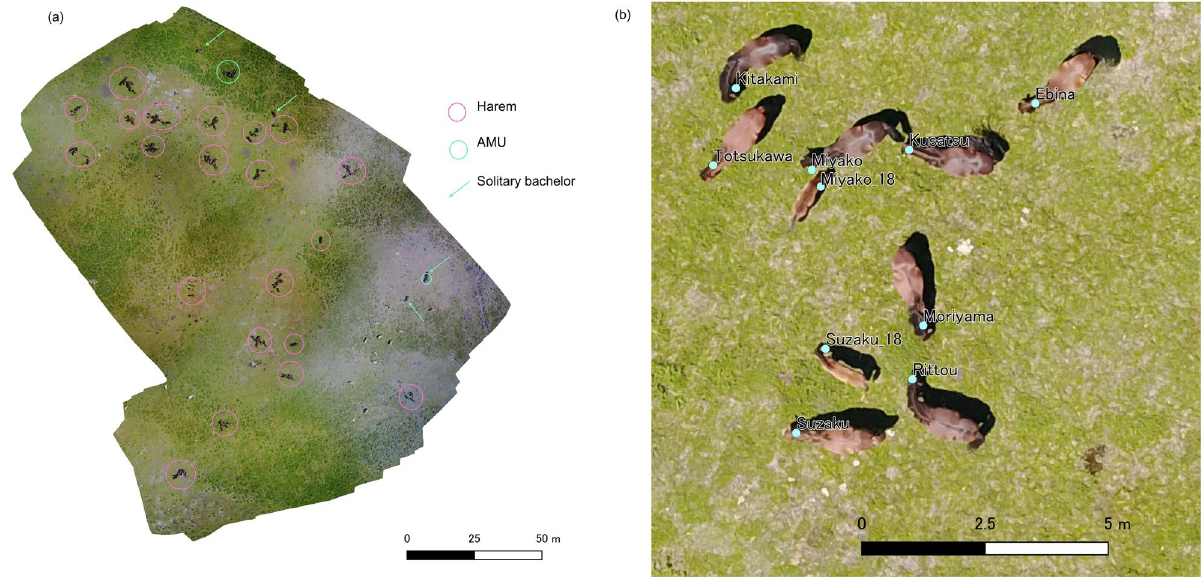
Figure 6. ( a ) An example of the orthomosaic created from the successive aerial images from a drone. Each brown dot on the field is a horse. Circles and arrows represent the units and solitary males partitioned based on the distance distribution (see the results for details). White dots are free-ranging cows. ( b ) The enlarged view of an orthomosaic. It captured an upright image of a harem named Kitakami. All horses on the orthomosaics were identified. The points and labels represent the positions and IDs of each horse. Infants were named as “mother’s name”_18. Both of the images were created using AgiSoft Photoscan professional 1.4.3 (https ://www.agiso